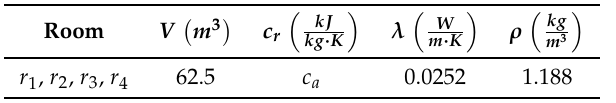
Table 4. The physical parameters of the particular rooms.